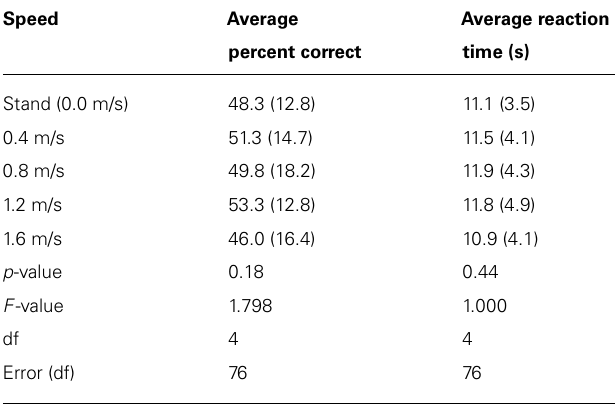
Table 1 |Average percent correct and average reaction time for the Brooks spatial memory task at all